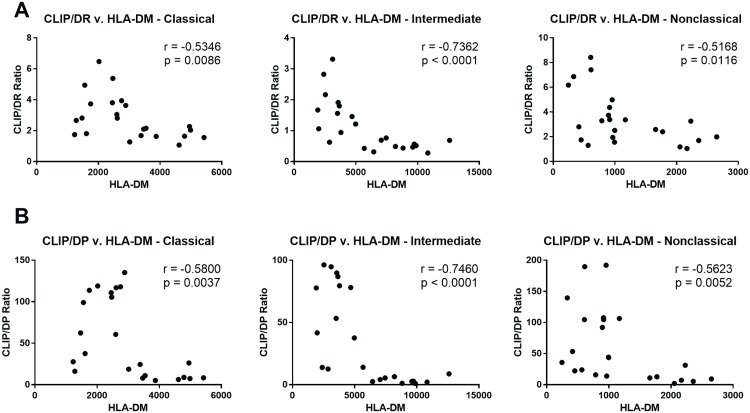
CLIP:DR and CLIP:DP ratios correlate negatively with HLA-DM expression in monocyte subsets.(A) Spearman correlation between the CLIP:HLA-DR ratios and HLA-DM MFI’s for the three monocyte subsets from 23 samples. (B) Spearman correlation between the CLIP:HLA-DP ratios and HLA-DM MFIs for the three monocyte subsets from 23 samples. All CLIP:MHCII ratios are multiplied by 100.